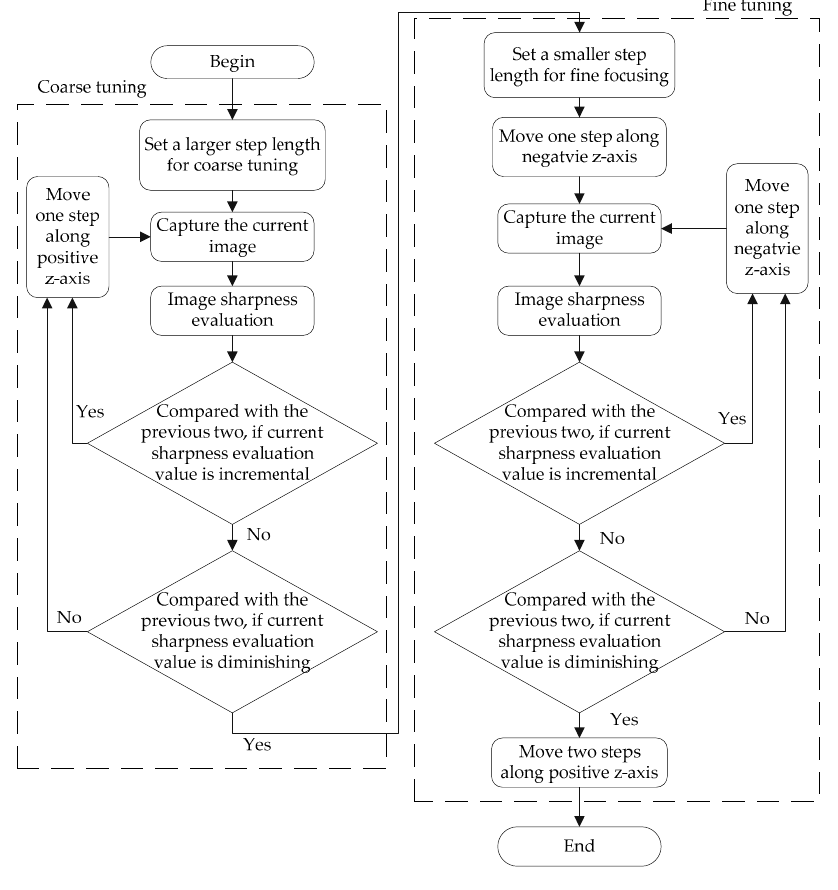
( a ) ( b ) Figure 6. Focusing curves with Brenner gradient function: ( a ) coarse focusing with a step length of 200 μ m; and ( b ) fine focusing with a step length of 50 μ m. 0